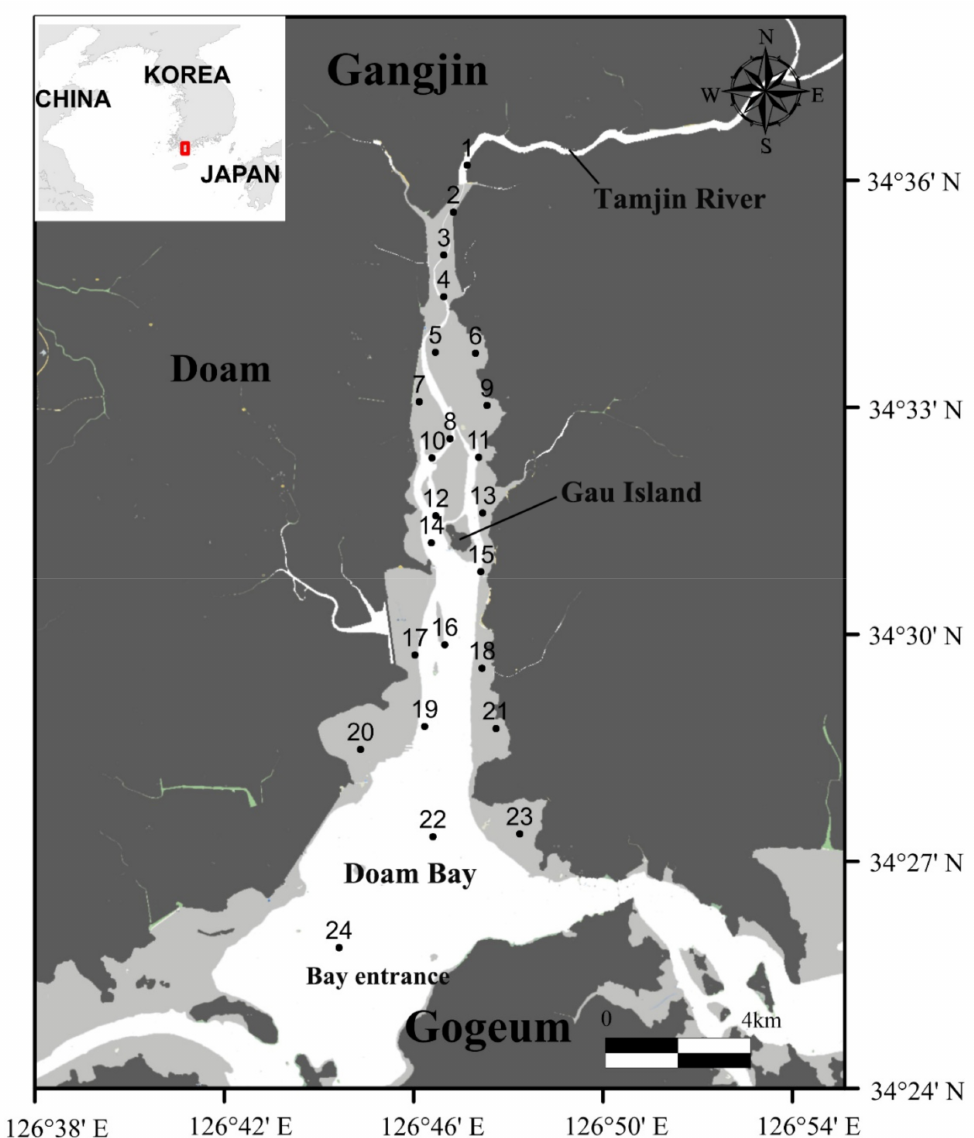
Figure 1. Map showing the sampling stations in Doam Bay, Korea. Light gray shaded regions indicate the shallow areas formed by sedimentation in the